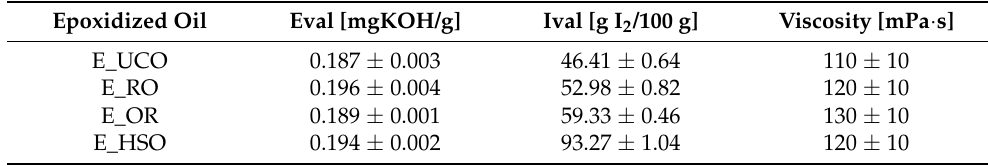
Table 4. Selected properties of the epoxidized oils.